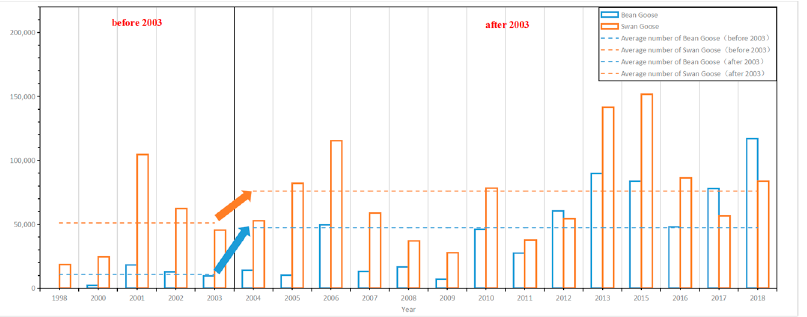
Figure 7. Statistics of species and quantity of Anseriformes in Poyang Lake (The red and bule arrows represent the change trend of the average number of quantity of Anseriformes).